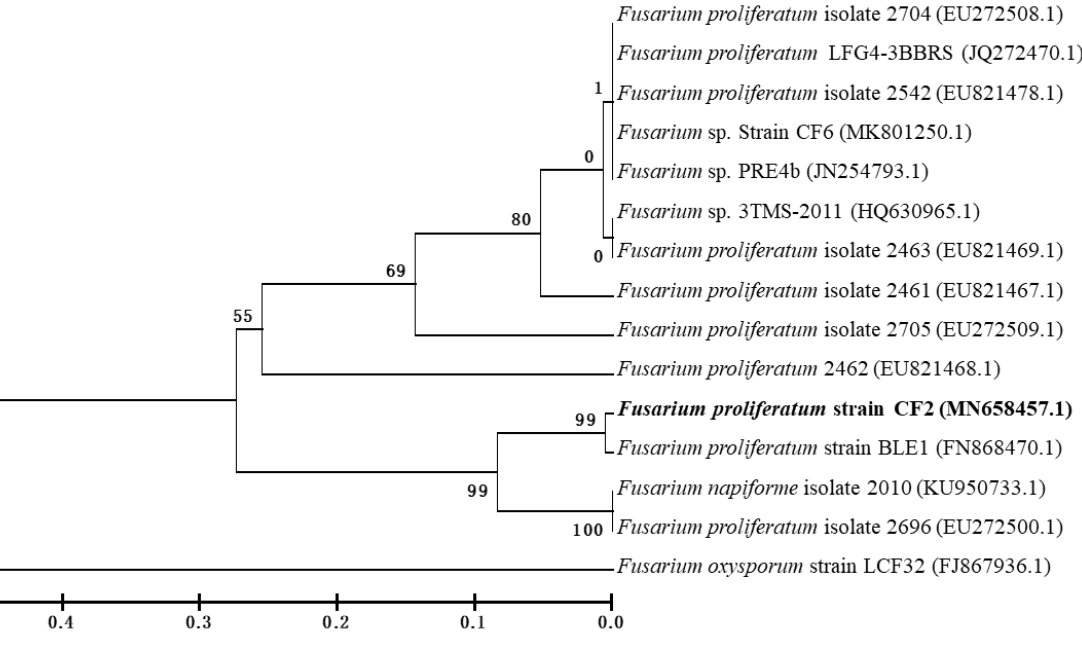
Figure 1. Phylogenetic relationships of the isolated strain CF2 and other closely related species on the basis of 5.8S rRNA sequences. The numbers at the nodes represent the accession numbers of GenBank. The bootstrap value for the unweighted pair group method with arithmetic mean (UPGMA) phylogenetic tree was 1000.